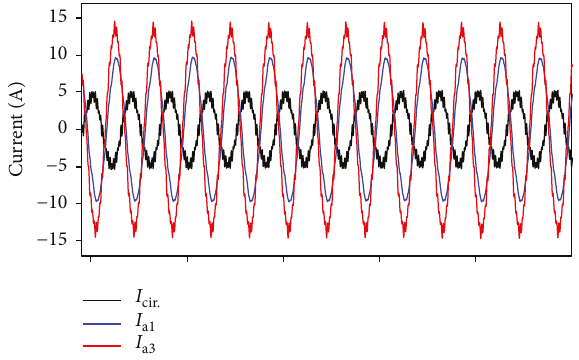
Figure 26: Circulating current with six-winding coupled inductors with a magnetizing inductance of 0.5mH.